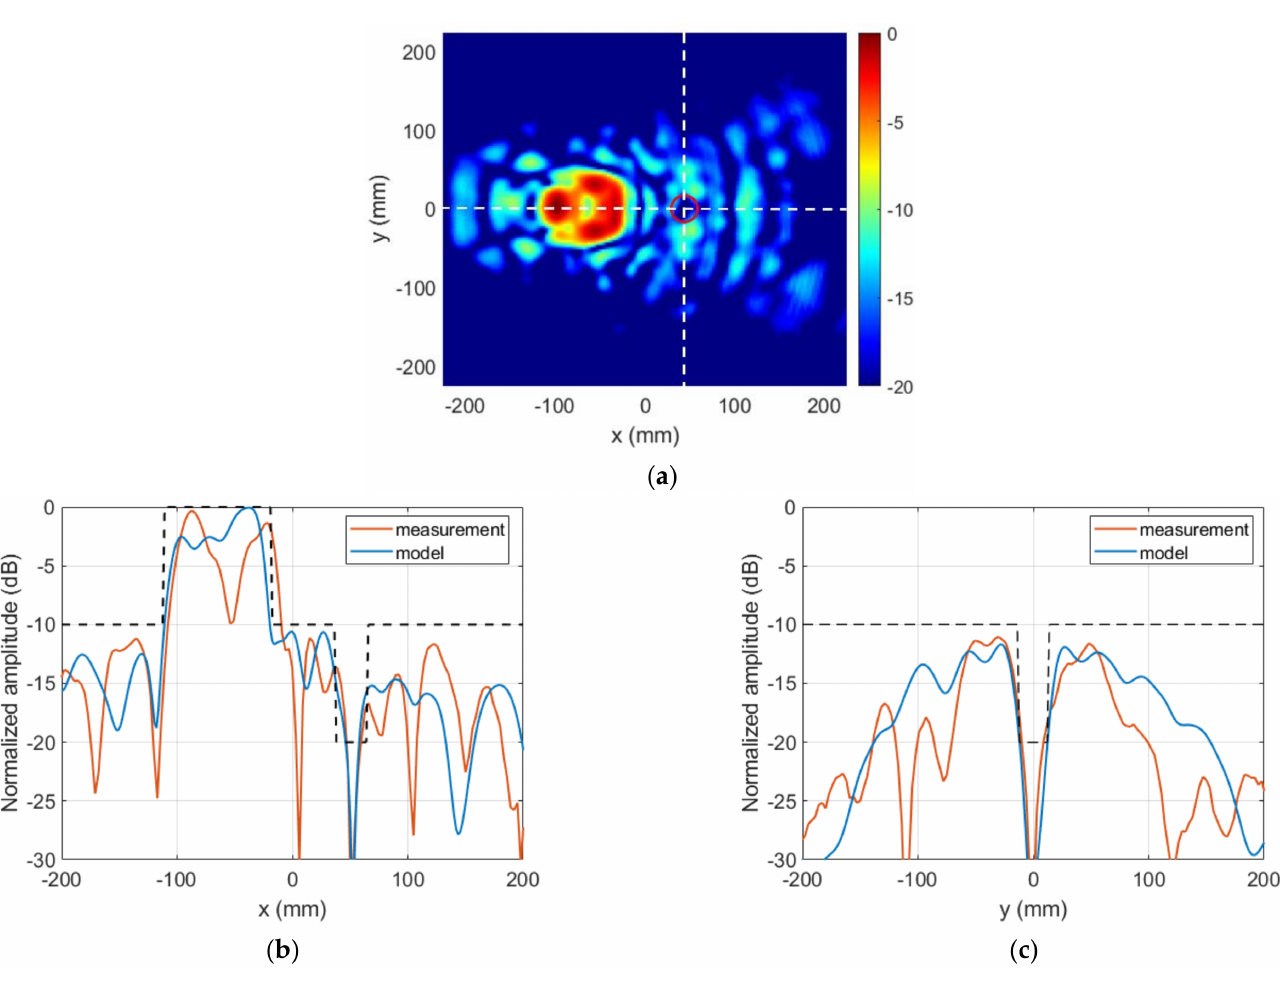
Figure 11. Case 1, NF results of the prototype. NF amplitude at z = D : ( a ) measurement (normalized amplitude, dB); ( b , c ) comparison of model result and